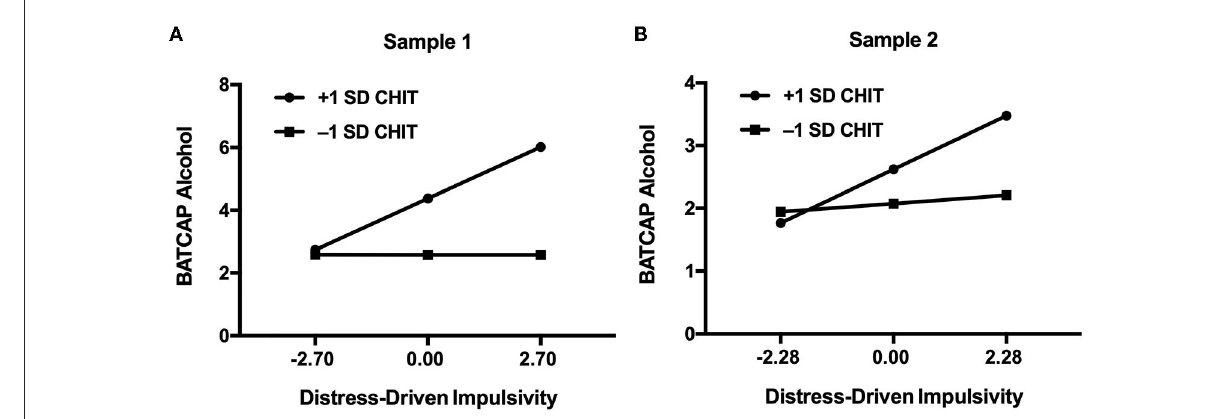
FIGURE1 Effect of distress-driven impulsivity on problematic drinking at different levels of trait compulsivity in Sample 1 (A) and Sample 2 (B)